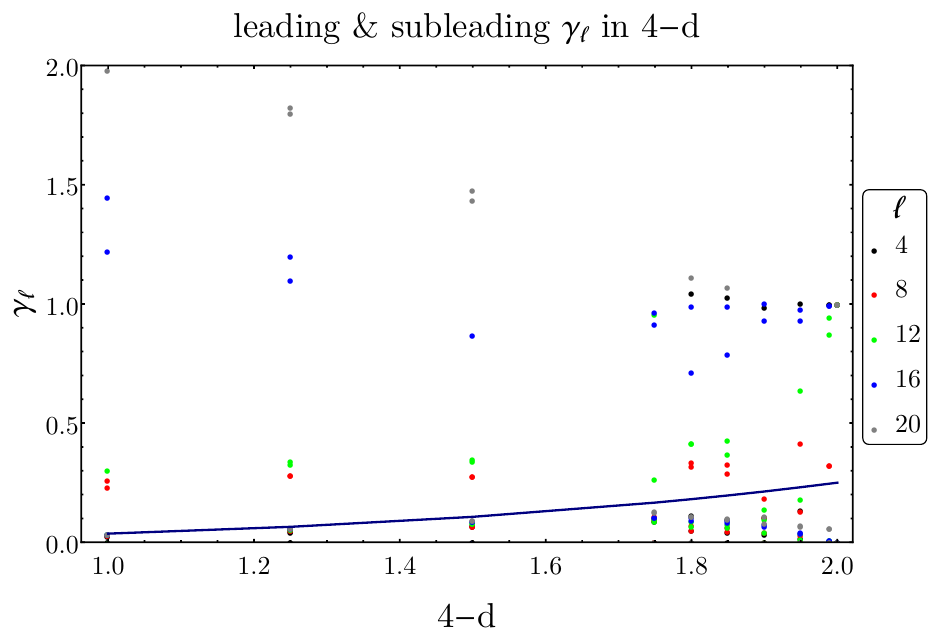
Figure 14 . Dimension dependence of anomalous dimensions (cid:13) ‘ (4 (cid:0) d ) for the subleading twists (above the curve) for some ‘ values. The blue curve shows the large ‘ asymptotic value equal to 2 (cid:13) (cid:27) (4 (cid:0) d